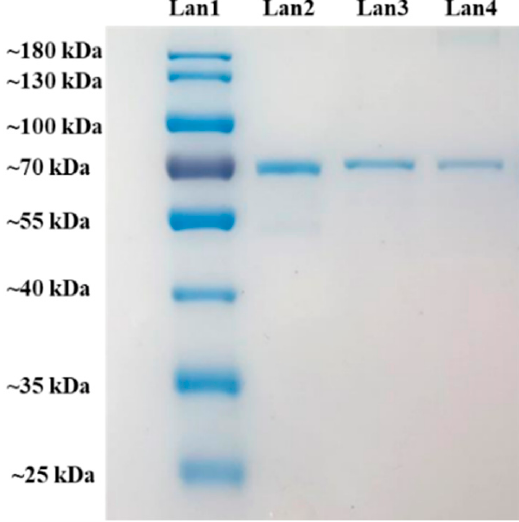
Figure 7. Sodium dodecyl sulfate polyacrylamide gel electrophoresis (SDS-PAGE) of MW ladder for comparison (Lan1), BSA reference (Lan2) and BSA from BSA-CS-NPs (Lan3) (CS concentration = 1 mg/mL, CS:TPP ratios ( w / w ) = 5:2.3, CS:TPP ratios ( v / v ) = 5:2) and Man-BSA-CS-NPs (Lan4) (CS concentration = 1 mg/mL, CS:TPP ratios ( w / w ) = 5:2.3, CS:TPP ratios ( v / v ) = 5:2, Man concentration = 3 mg/mL).